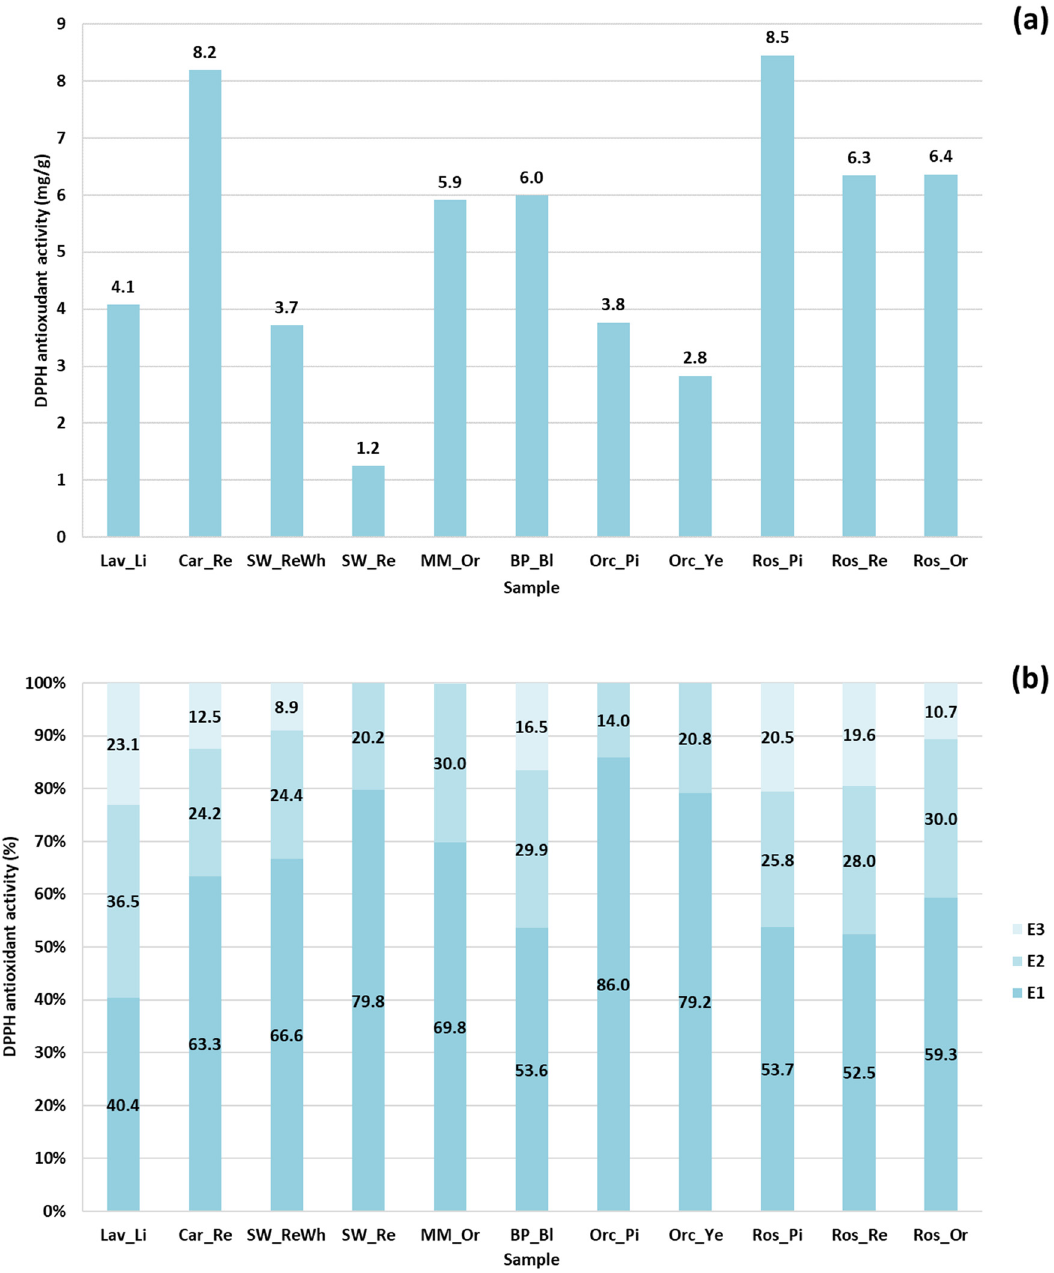
Figure 6: DPPH AOA in the fi rst extraction ( a ) and relative percentage of three extractions ( b )